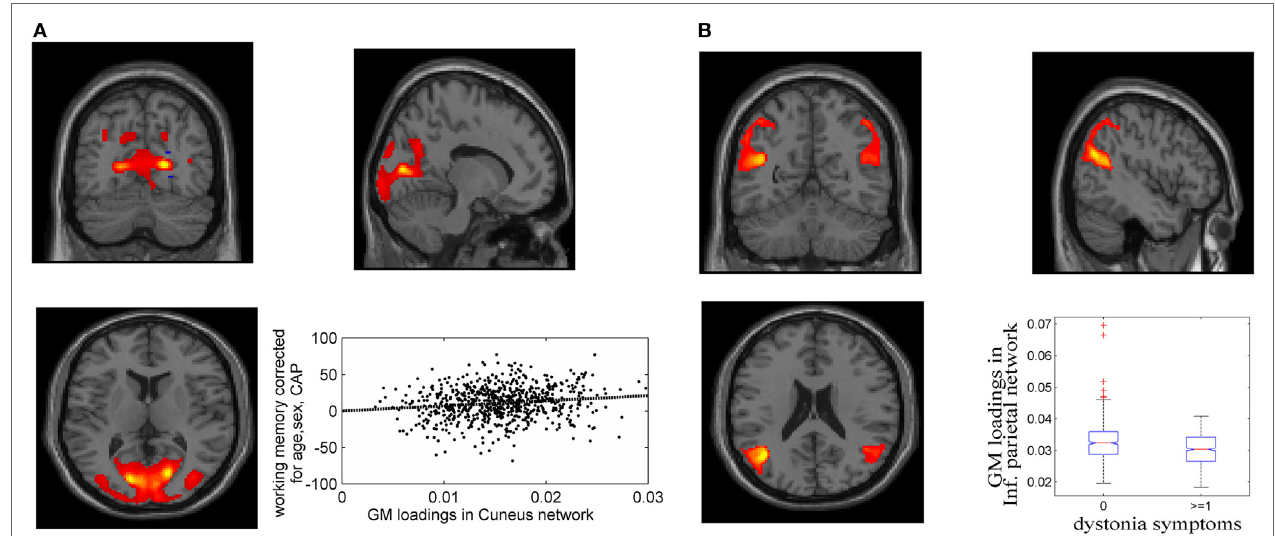
FigUre 1 | Gray matter (GM) components associated with working memory/attention and dystonia after controlling for disease burden. (a) GM component containing cuneus, lingual gyrus, and middle occipital gyrus, and its association with working memory/attention. (B) GM component highlighting bilateral inferior parietal and superior/middle temporal gyri, and its association with dystonia. The GM loadings are relative values without